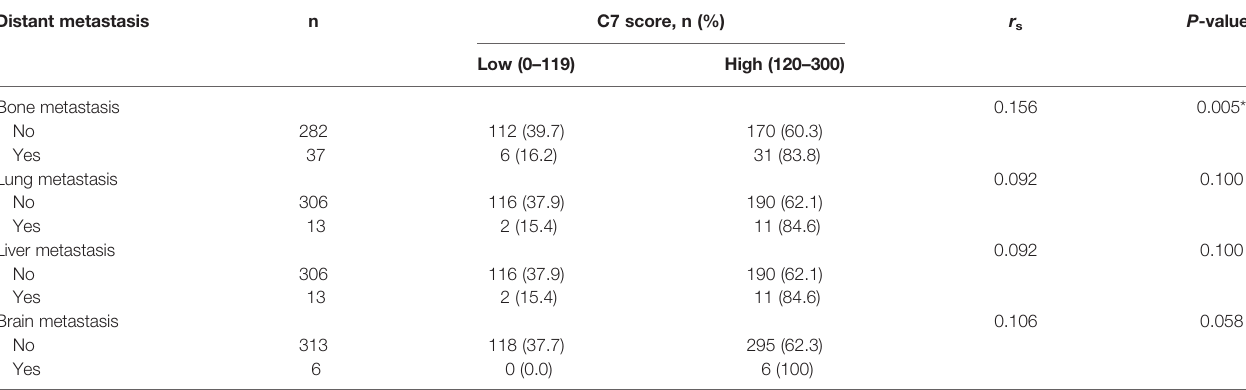
TABLE 4 | Relationship between C7 expression and distant metastasis in IDC patients. Distant metastasis